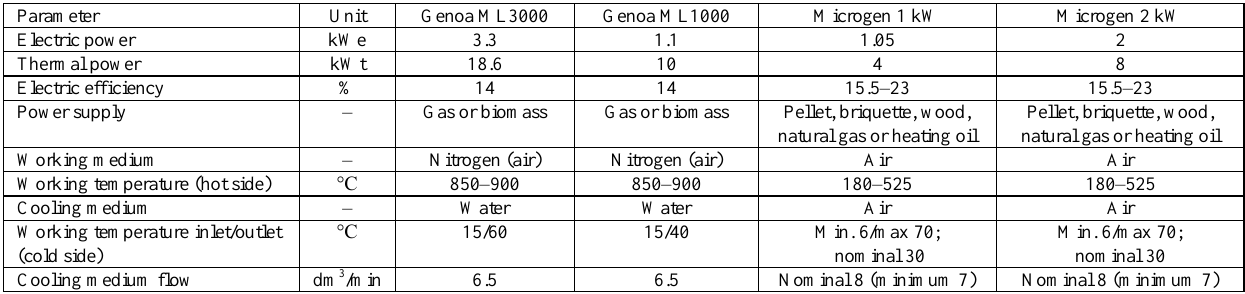
Table 1. Technical specification of Genoa Stirling and